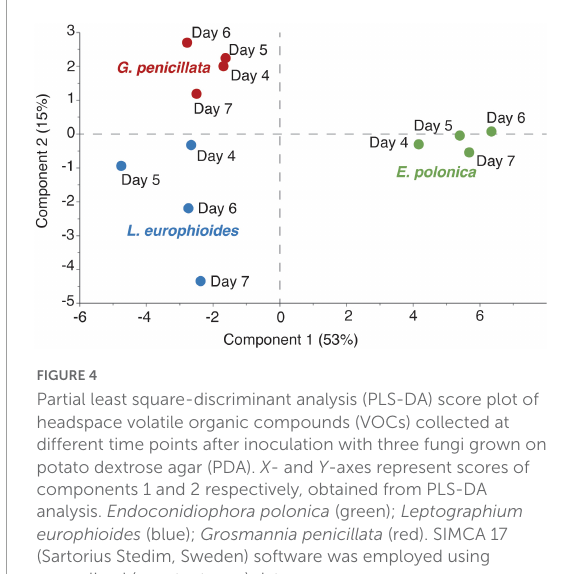
FIGURE3 Percentage trap catches of Ips typographus in pheromone traps baited with dispensers containing a mixture of 3-methyl-1-butanol, 2-methyl-1-butanol, 3-methyl-1-butylacetate, 2-phenylethanol, 2-methyl-1-butylacetate, and 2-phenylethylacetate in equal volume ratio 1:1:1:1:1:1 (v/v). Dispensers denoted as MixL, MixM, and MixH have release rate of 0.34, 1.7, and 8.4 mg/day, respectively; pheromone: pheromone consisting of 2-methyl-3-buten-2-ol and cis -verbenol with a release rate of 42 and 1.5 mg/day, respectively. Whiskers represent 95% CI, black dots are the predicted mean generated by the linear regression model and orange dots are original values. The absolute number of beetles caught in synthetic VOC dispensers without pheromones ranged from 0 to 6. The empty control traps did not catch any beetle. Only the MixH bait caught some beetles, but the catches were meager, with a maximum of six ( Supplementary Tables 8, 9 ).